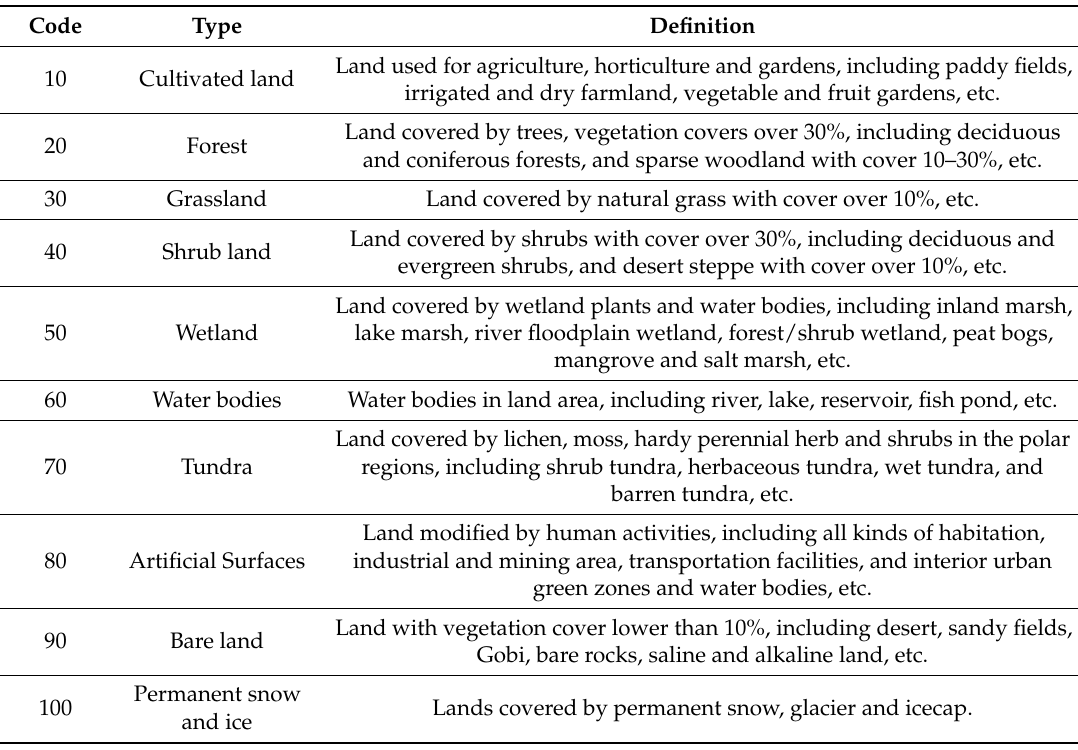
Figure 1. Map of GlobeLand30 (2010). Table 1. Classification, codes, and definition of each land cover type of GlobeLand30.